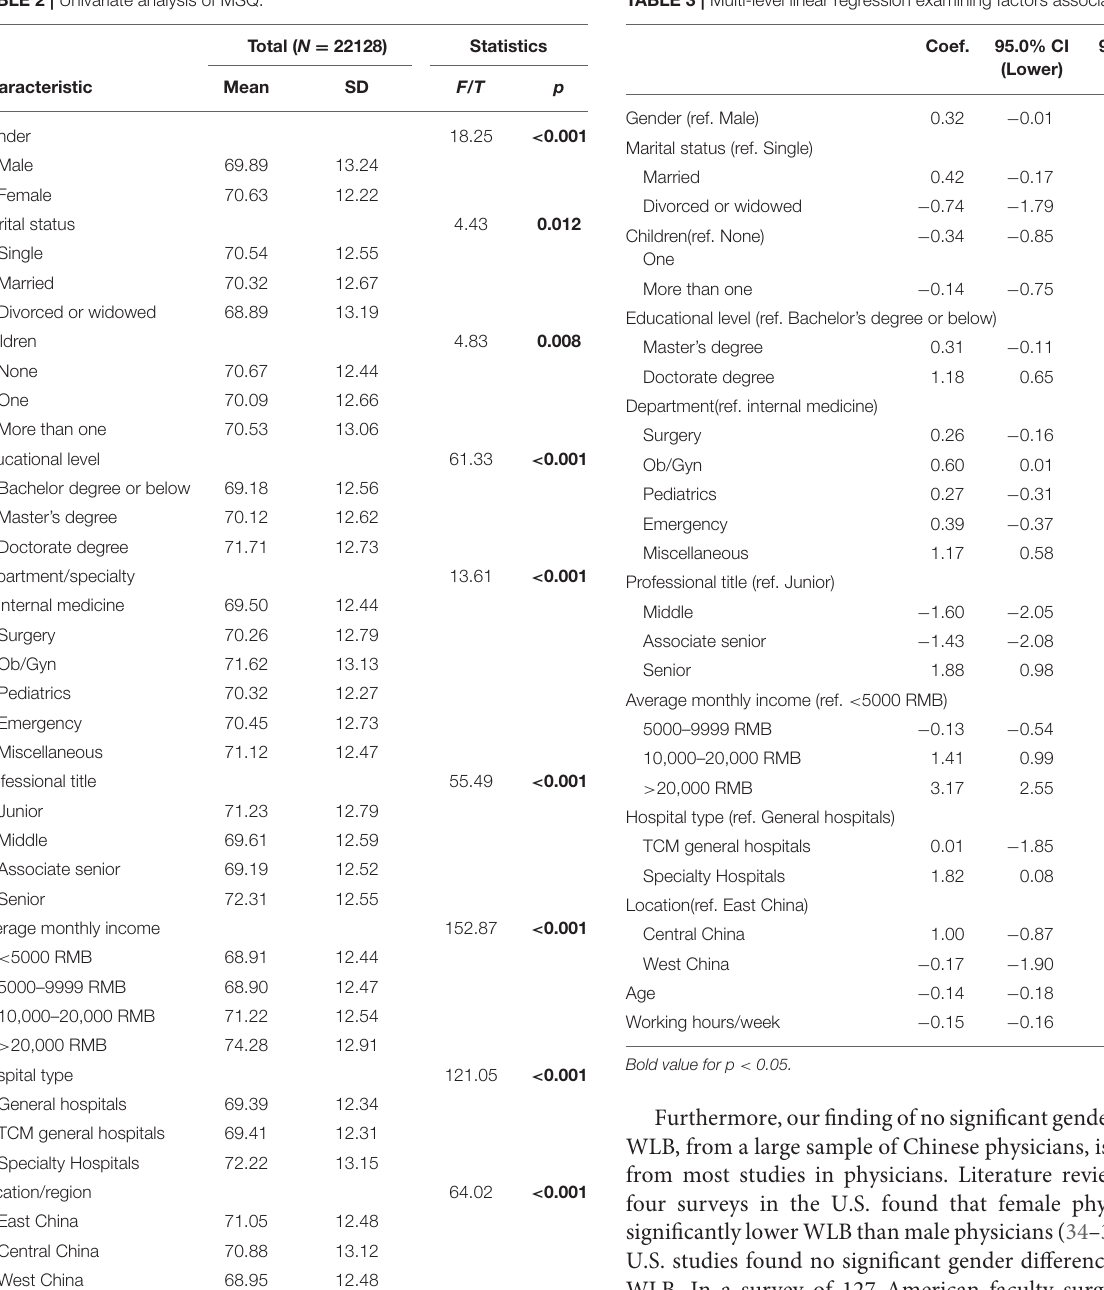
TABLE 2 | Univariate analysis of MSQ.